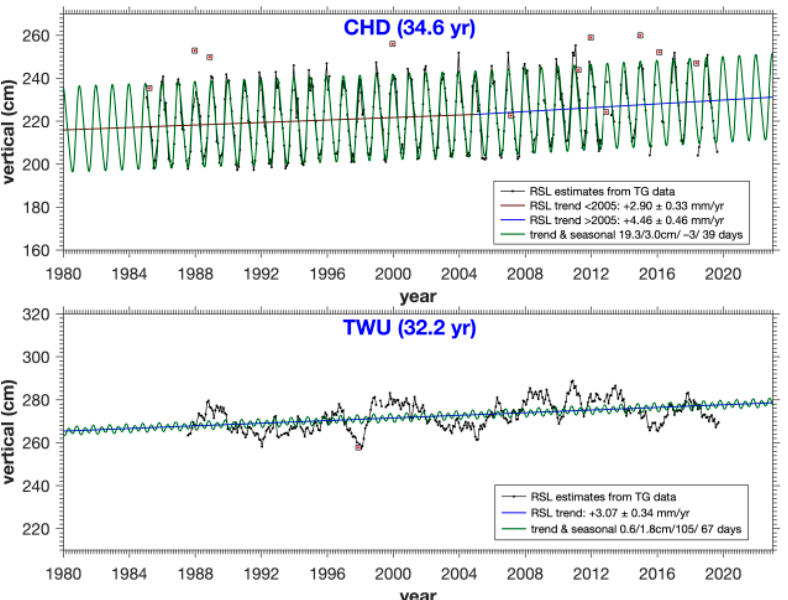
Figure 3. Relative sea level (RSL) trend and annual and semi-annual estimates from the tide-gauge time series (1984–2019) for CHD (Kuala Terengganu) in Peninsular Malaysia (split trend lines) and TWU (Tawau) in Sabah, East Malaysia. For each tide-gauge location, the vertical position time series is given along with the total observation period. The linear trend lines are shown in brown (<2005) and blue (>2005) (CHD split trend) and blue (>1988) (TWU single trend) with the modeled seasonal (annual) signal (green) superimposed. Monthly position outliers are marked in red. The tide-gauge trend estimates are given at a 95% (1.96 sigma) confidence level.